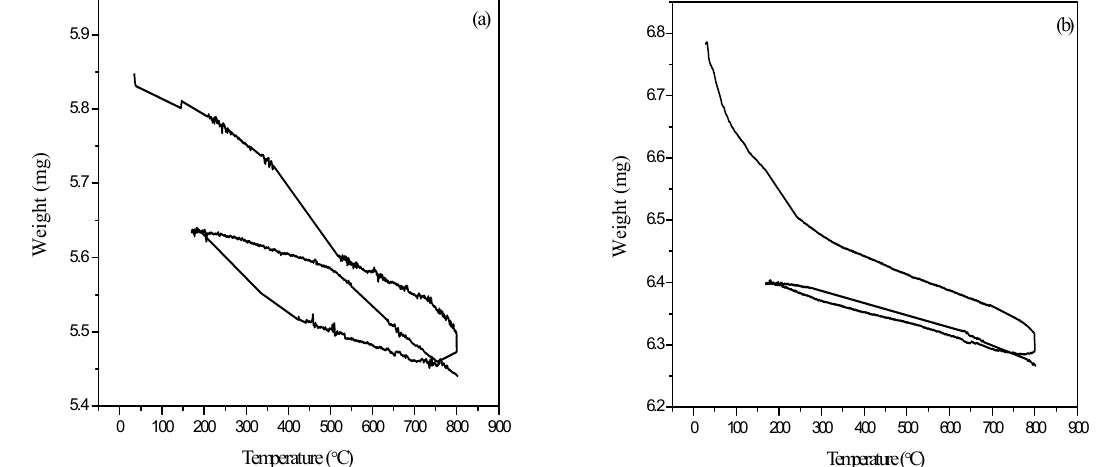
Figure 4. Plots for measurements of oxygen storage capacity (OSC) of ( a ) Co 3 O 4 / TiO 2 and ( b ) 8 wt.% ZrO 2 -Co 3 O 4 / TiO 2 .